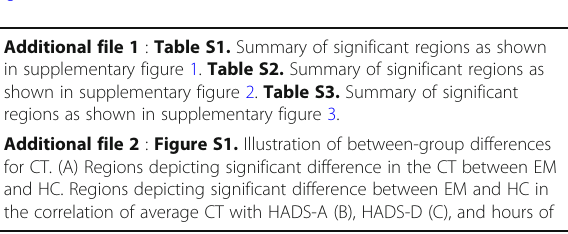
Additional file 1 : Table S1. Summary of significant regions as shown in supplementary figure 1. Table S2. Summary of significant regions as shown in supplementary figure 2. Table S3. Summary of significant regions as shown in supplementary figure 3. Additional file 2 : Figure S1. Illustration of between-group differences for CT. (A) Regions depicting significant difference in the CT between EM and HC. Regions depicting significant difference between EM and HC in the correlation of average CT with HADS-A (B), HADS-D (C), and hours of